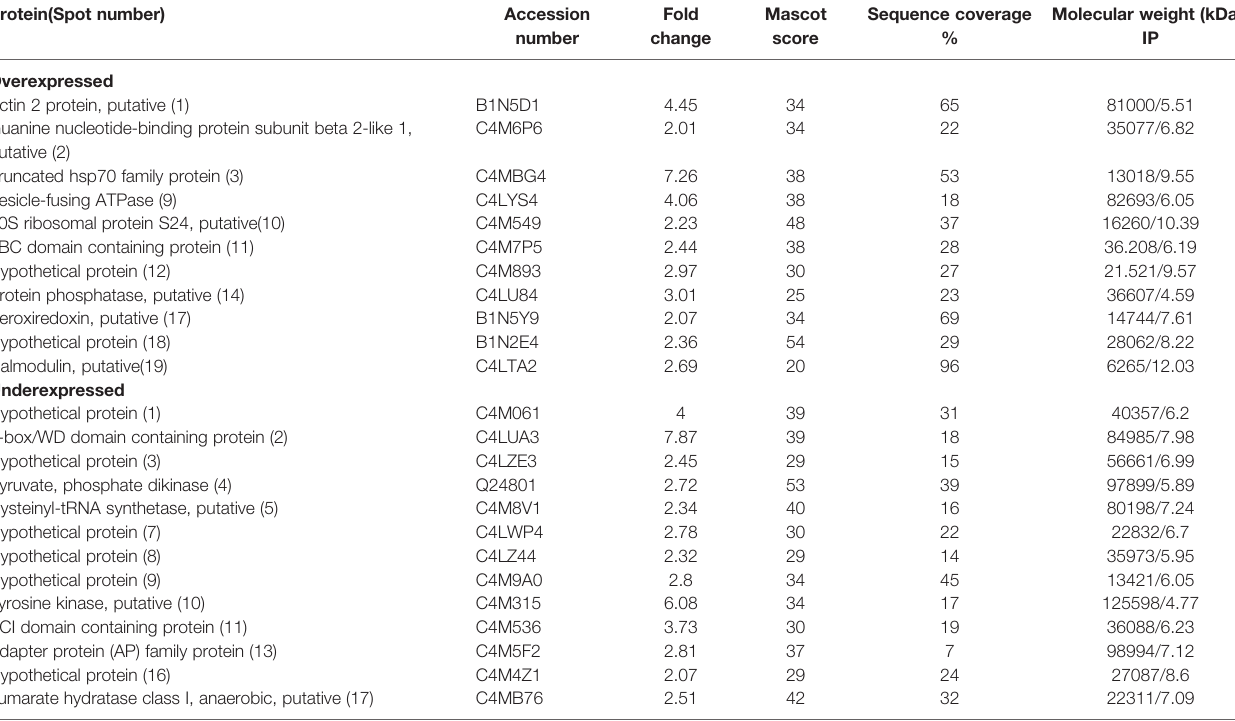
TABLE 1 | Identi fi cation of E. histolytica proteins that are modulated by QdNO T-001. Protein(Spot